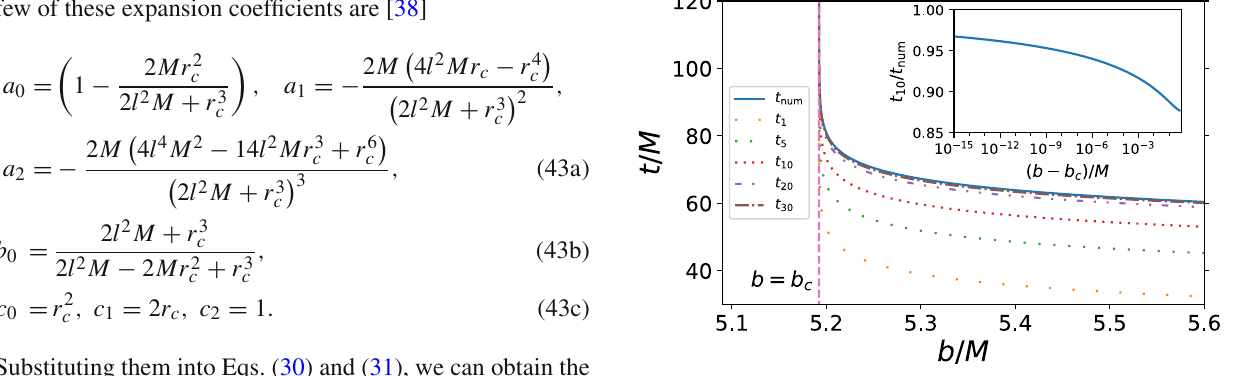
Fig. 2 Total travel time in Hayward spacetime as a function of b using truncated series (48) (dashed or dotted lines) and the exact result using numerical integration of Eq. (6) (the solid line). Inset: the ratio between the result truncated at order 10 and the numerical